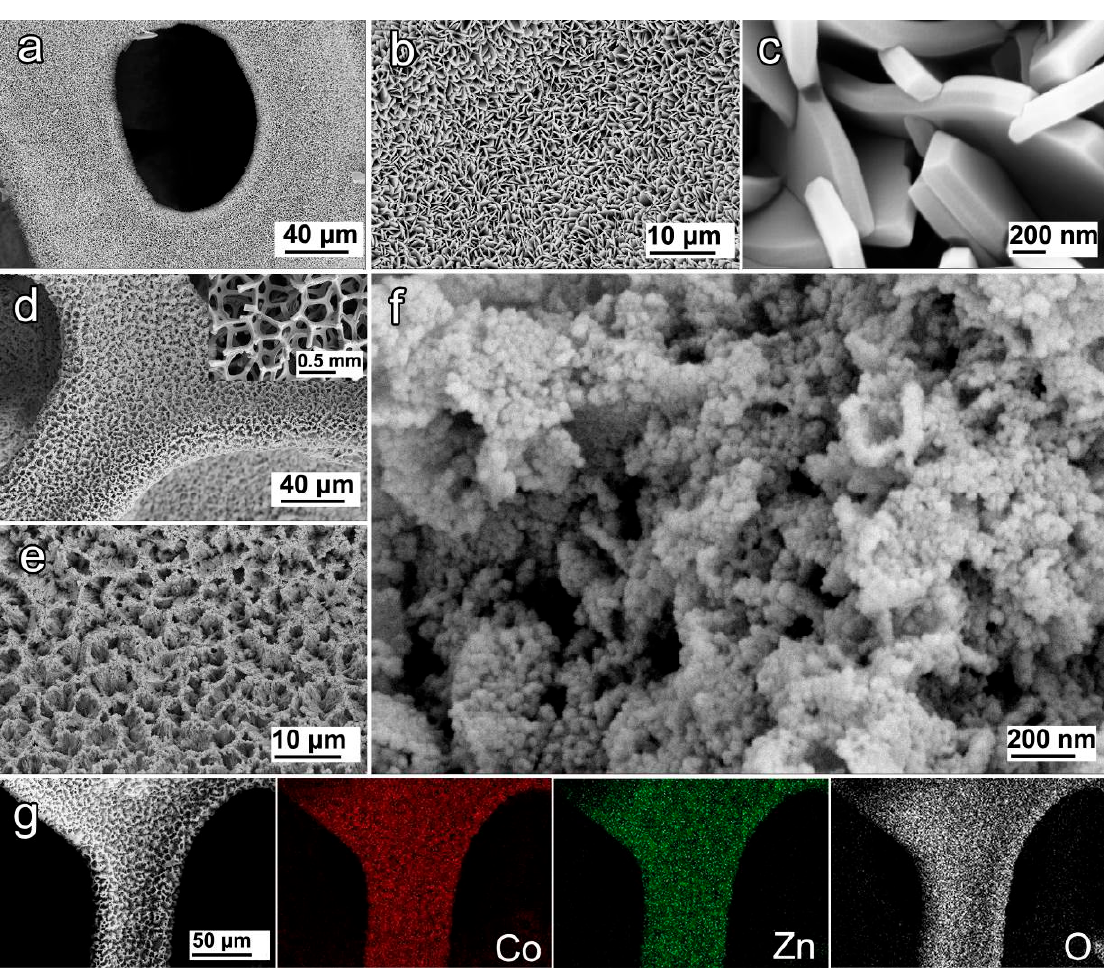
Figure 2. SEM images of ( a–c ) CoZn-MOF-45 (cobalt–zinc-based metal–organic framework) precursor and ( d–f ) as-prepared CoZn-MOH-45-110 supported on nickel foam. The inset of ( d ) is its low-magnification SEM image. ( g ) SEM elemental mapping of CoZn-MOH-45-110 supported on nickel foam.